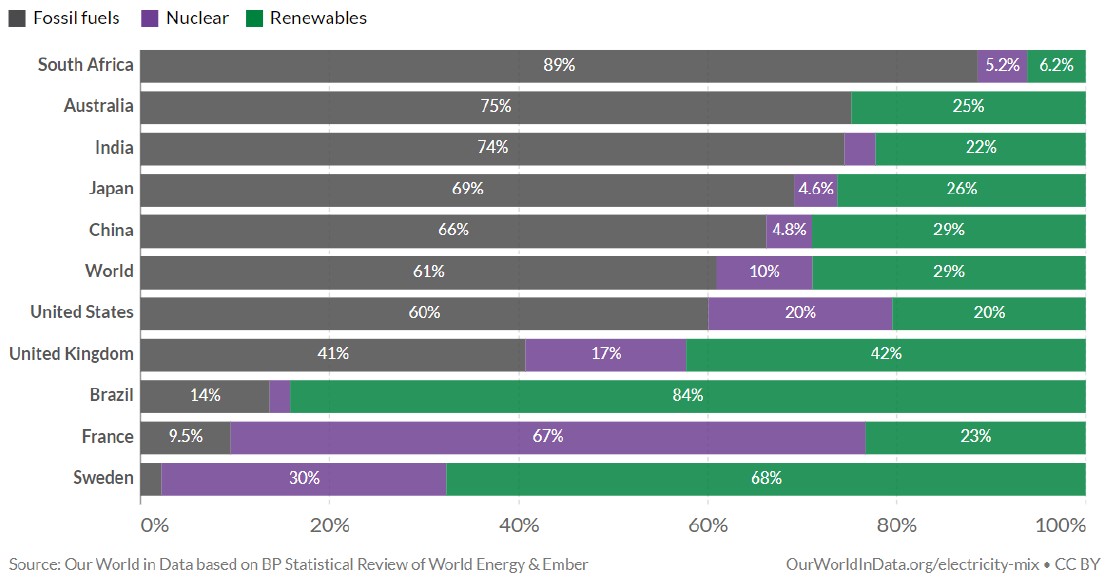
Figure 6. Per capita electricity from fossil fuels, nuclear and renewables, 2020 (Source: https://ourworldindata.org/electricity-mix, last accessed on 21 December 2021).